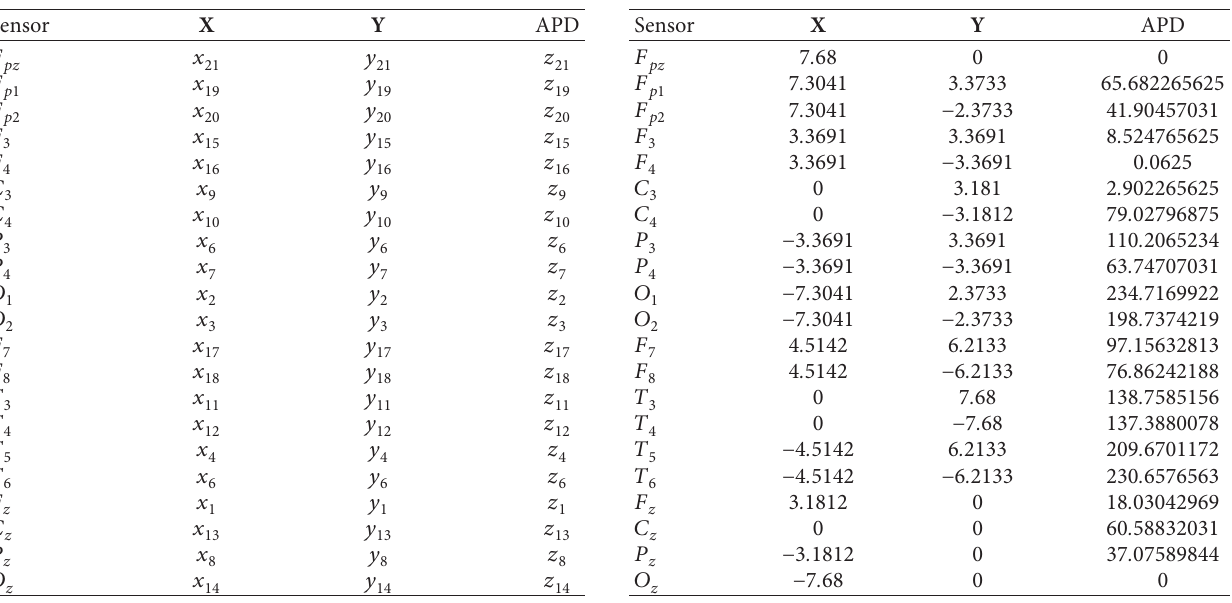
Table 4: Average potential difference (APD) for patient A at the sensor on an MC at time t � 3 [30].